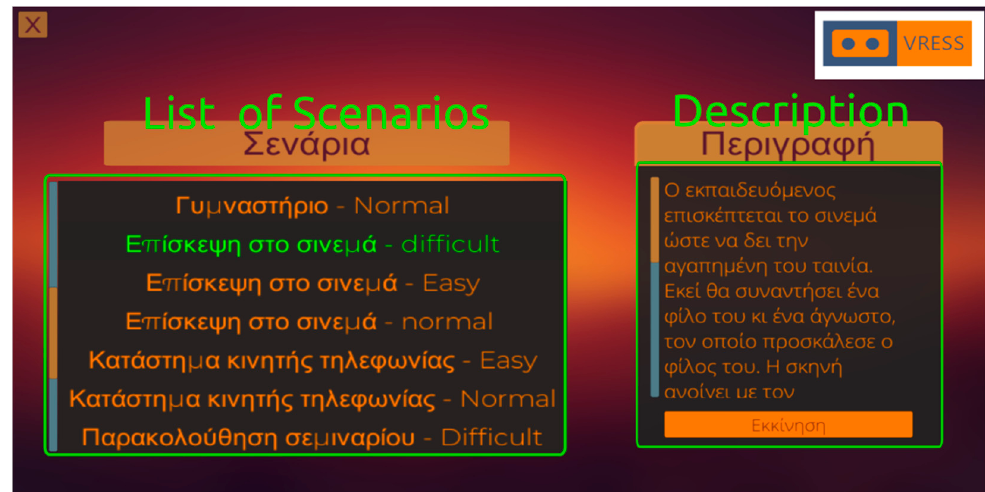
Figure 1. Central User Interface for selecting the social scenario ( Left ) and describing the requirements to the user ( Right ).